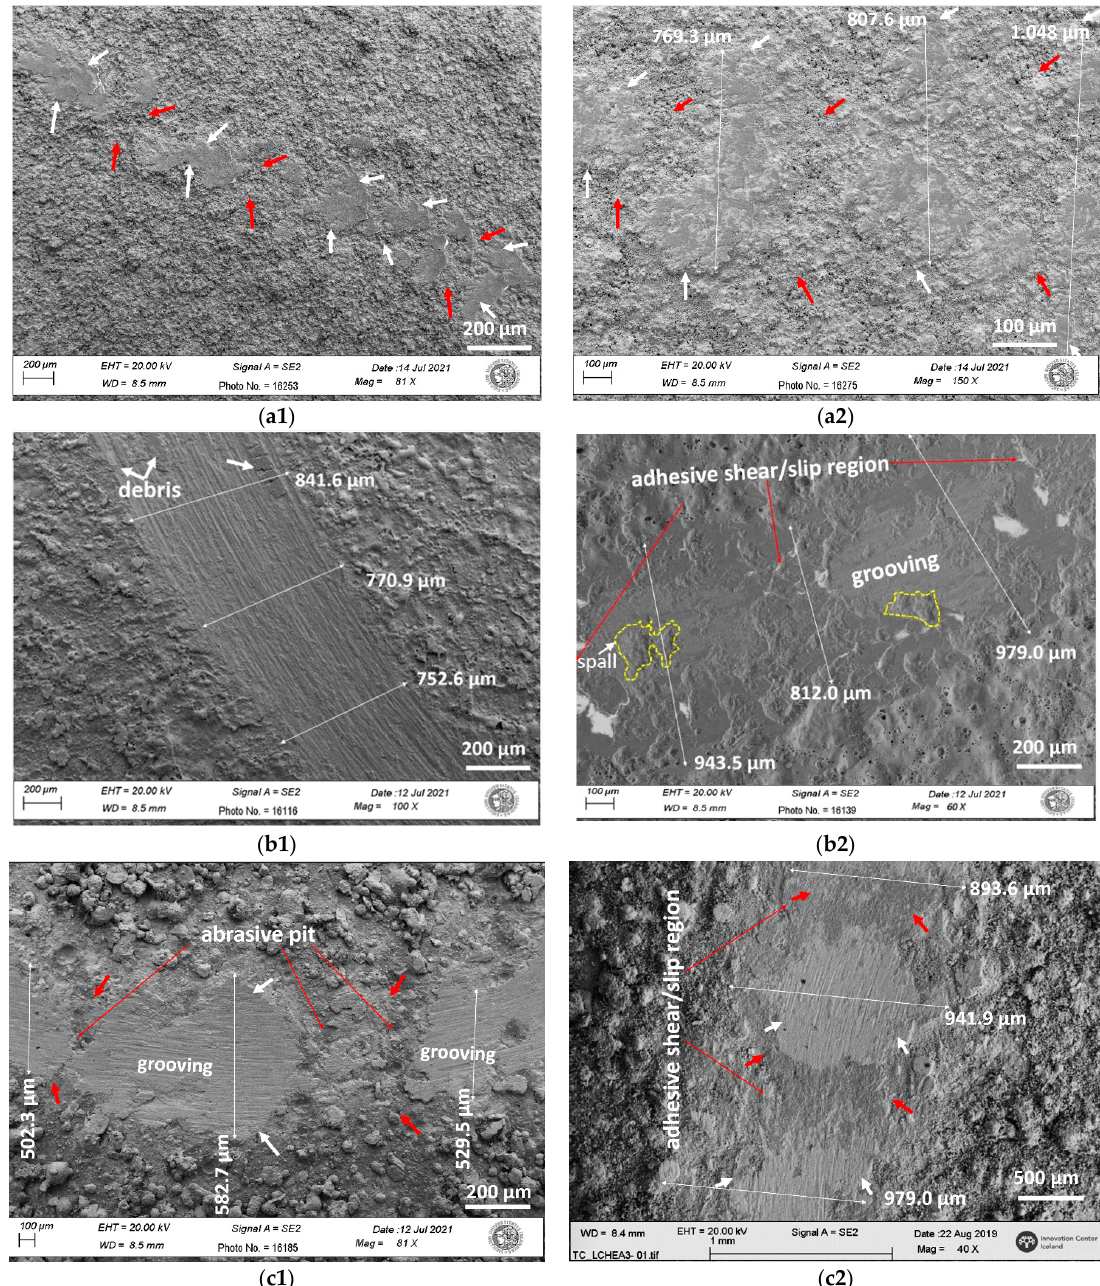
Figure 12. SEM micrographs of morphology of the wear tracks of the ( a1 ) HVOF-HEA_Mo 27 , ( b1 ) ESD-HEA_Mo 27 , ( c1 ) LC-HEA_Mo 27 and ( a2 ) HVOF-HEA_Mo 20 , ( b2 ) ESD-HEA_Mo 20 , ( c2 ) LC- HEA_Mo 20 —CoCrFeNiMo coatings with the different coating techniques after 12,000 wear cycles under dry test